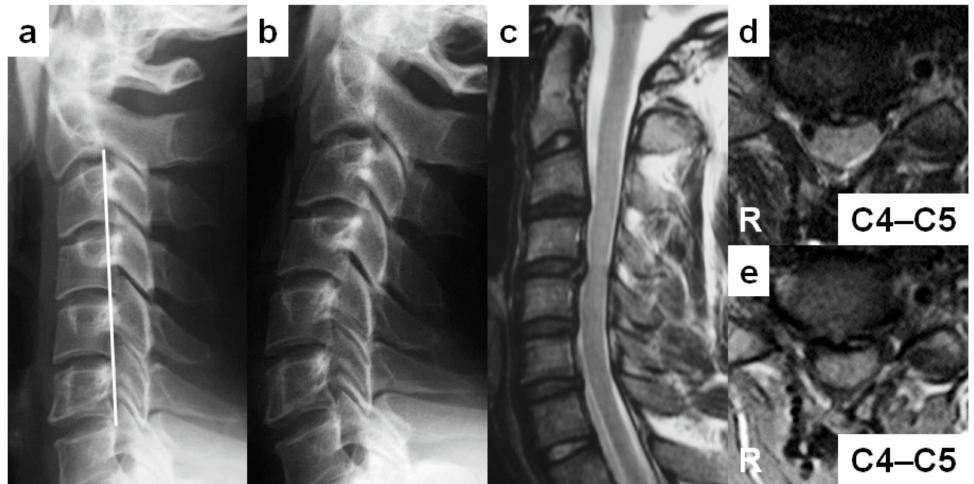
Figure 3. Report of a 24-year-old man with cervical spondylotic myelopathy (case no. 3). ( a , b ) Lateral cervical spine radiographs in neutral ( a ) and full-extension ( b ) positions demonstrating the “reverse- sigmoid” sagittal cervical alignment and posterior vertebral slip at C4. ( c ) A sagittal T2-weighted magnetic resonance image (MRI) demonstrating “degenerative” discs from C3–C4 to C6–C7, spinal cord compression at C4–C5, and no intramedullary increased signal intensity lesions. ( d ) An axial T2-weighted MRI demonstrating the narrowed cervical spinal canal without any intramedullary increased signal intensity areas at C4–C5. ( e ) An axial T1-weighted MRI demonstrating the “ovoid” spinal deformity at